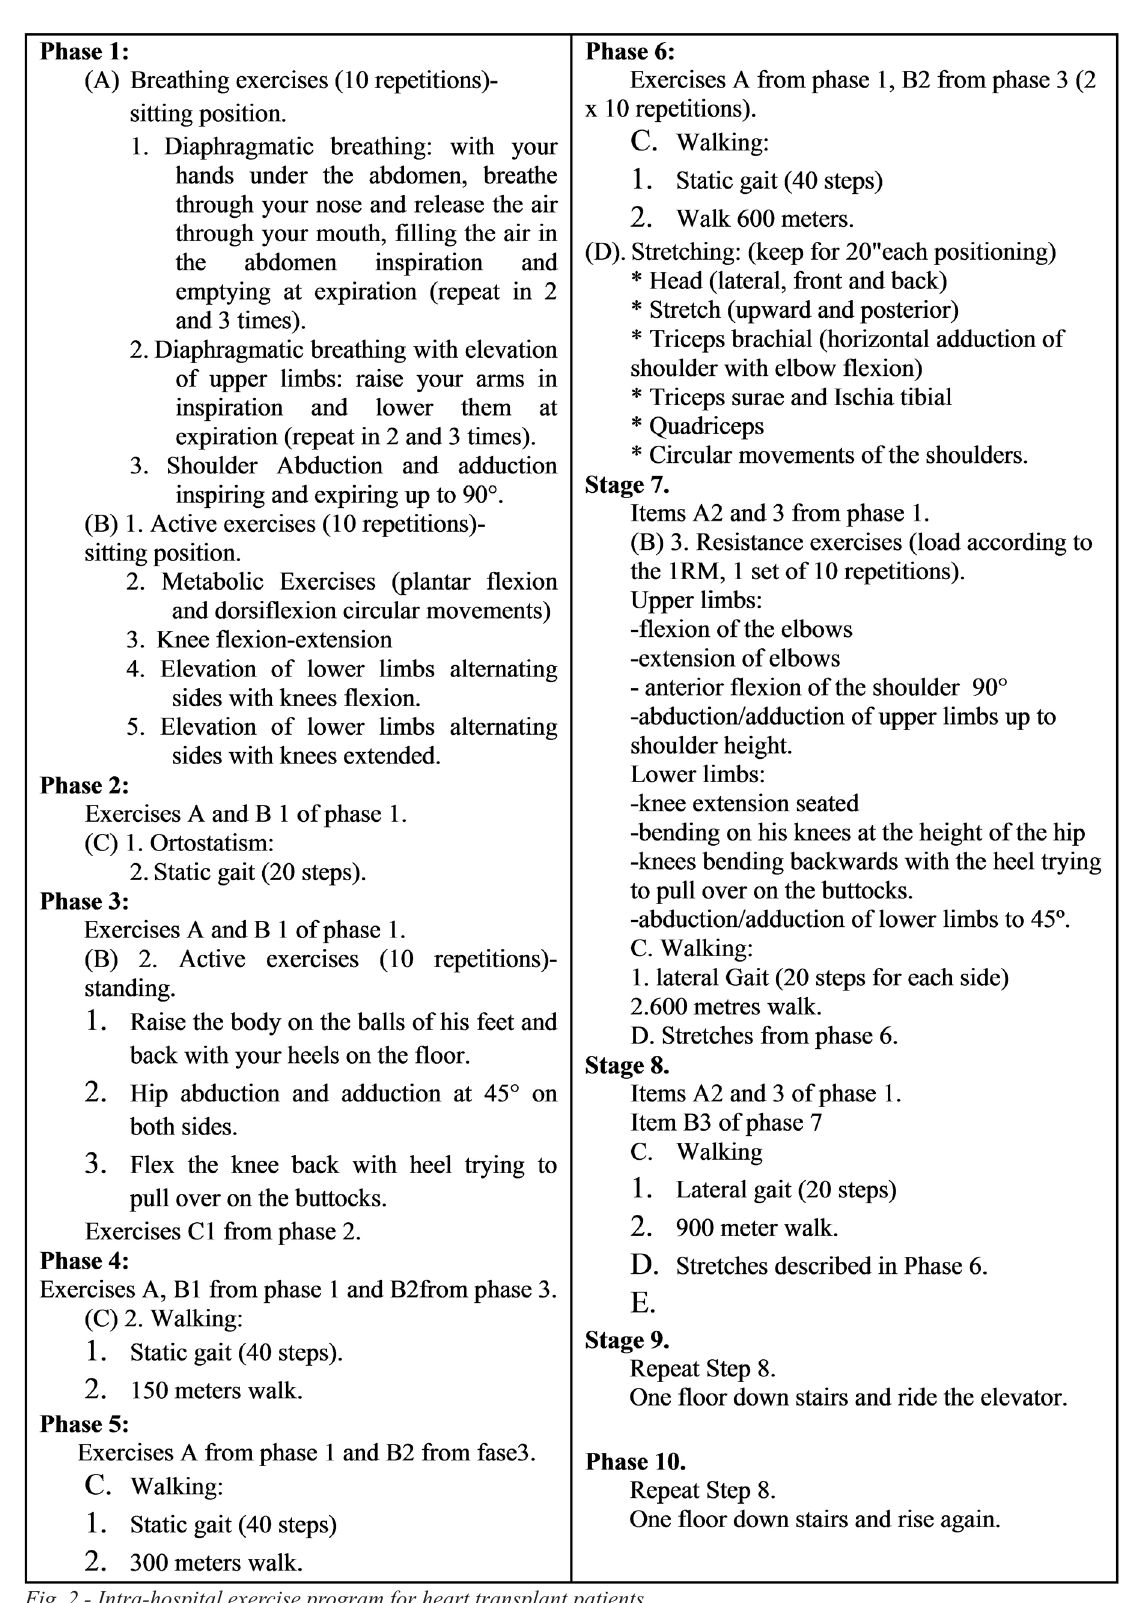
Fig. 2 - Intra-hospital exercise program for heart transplant